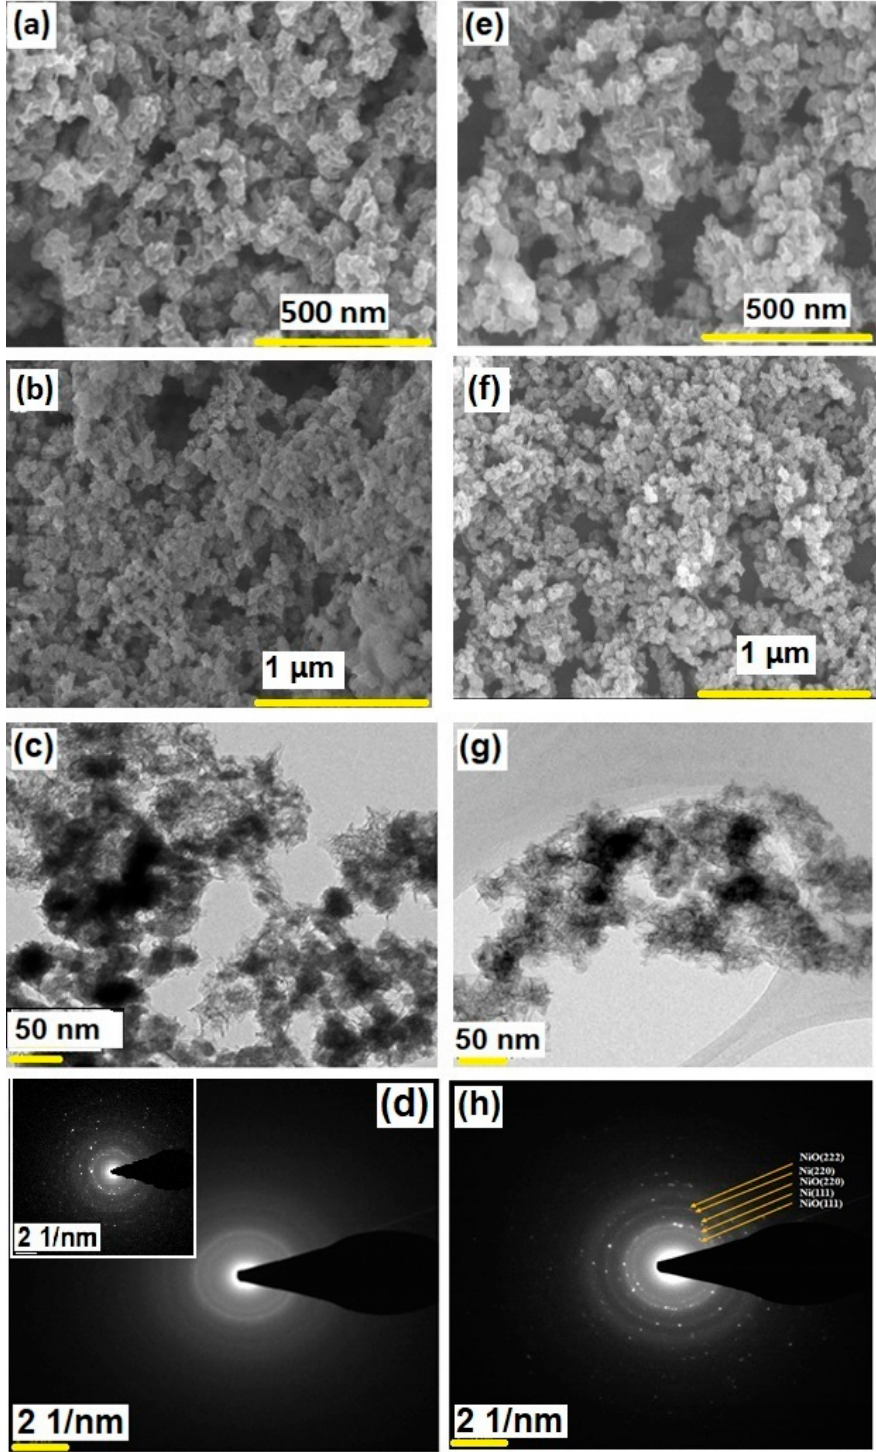
Figure 1. ( a , b ) FESEM images of α -Ni(OH) 2 and ( e , f ) NiO/Ni, HRTEM images of ( c ) α -Ni(OH) 2 and ( g ) NiO/Ni, and corresponding SAED patterns of ( d ) α -Ni(OH) 2 and ( h ) NiO/Ni. (Inset in figure ( d ) shows the SAED pattern of α -Ni(OH) 2 ).